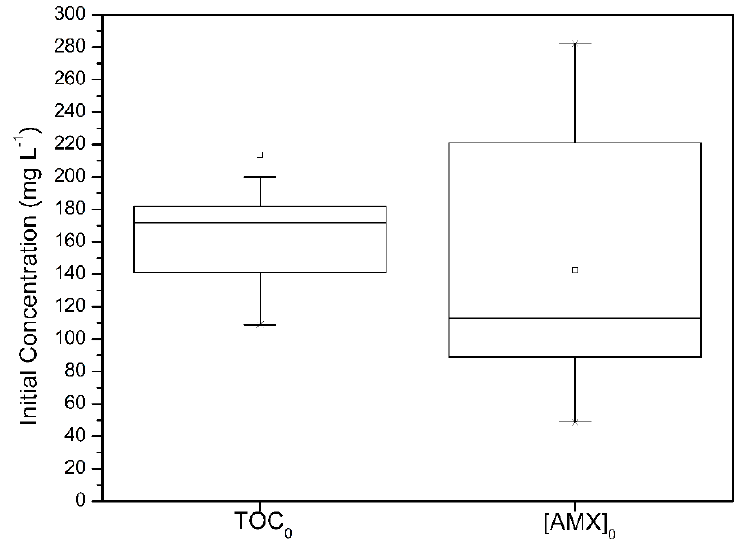
Figure 4. Boxplot of [AMX] 0 and [TOC] 0 as a function of the mass of pharmaceutical formulation (sample size, n = 25). Pharmaceutical formulation mass of (1.5049 ± 0.0053) g. (mean ± standard deviation). Reaction volume = 3.00 L.